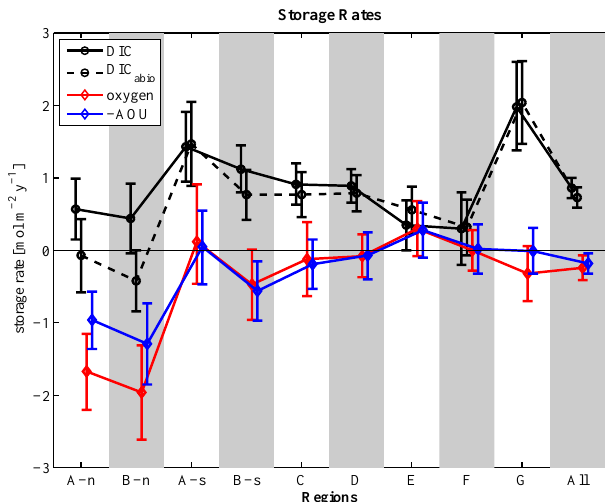
Fig. 6. Graphical representation of the storage rates for DIC, DIC abio , oxygen and AOU for the 9 regions (regions C–G and the northern and southern sub-regions for A and B) as well as the whole Atlantic Ocean. The vertical error bars represent the 95% confi- dence interval of the